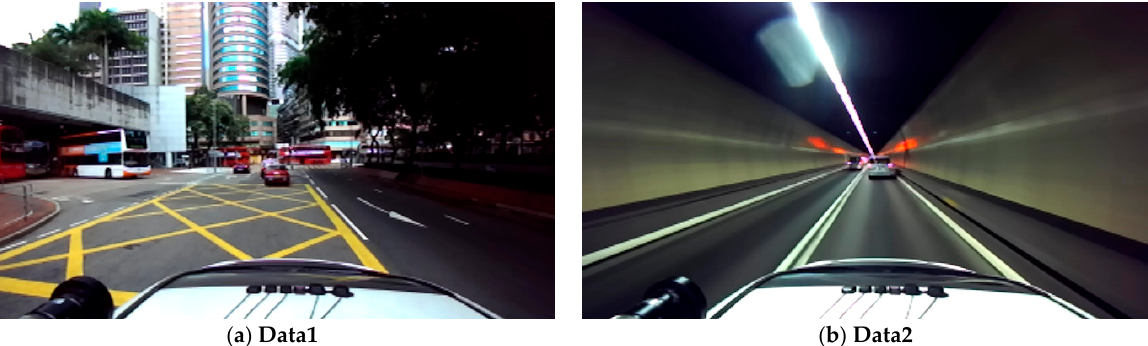
Figure 8. Demonstration of the scenarios in the three urban datasets. ( a ) Data1: Variety of dynamic vehicles and numerous high-rising buildings in UrbanNav-HK-Medium-Urban-1. ( b ) Data2: Closed tunnel in UrbanNav-HK-Tunnel-1.